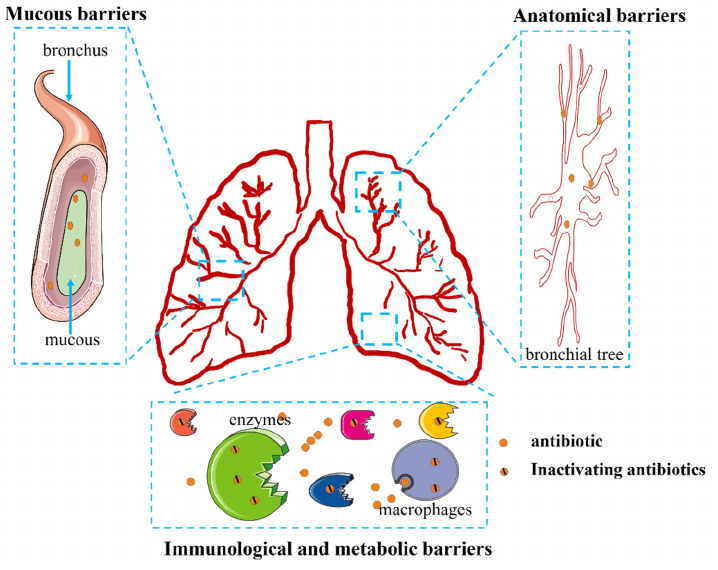
Figure 6. Challenges in the local delivery of